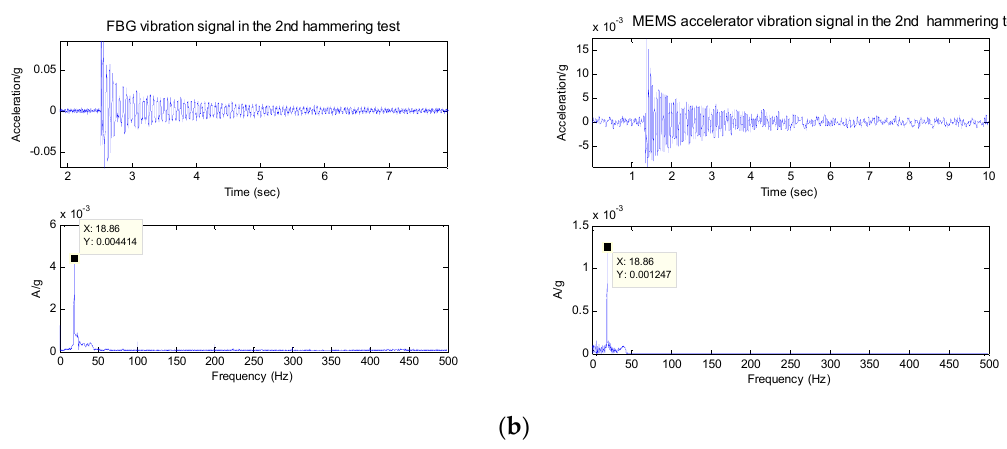
Figure 12. The responsivity of the two kinds of sensors’ signals for the hammering excitation experiment. ( a ) The time domain and spectrum of the two kinds of sensors for the 1st hammering excitation experiment; ( b ) The time domain and spectrum of the two kinds of sensors for the 2nd hammering excitation experiment. Table 1. The resonance frequency of micro-vibration structure obtained by the MEMS and FBG micro-vibration sensor.